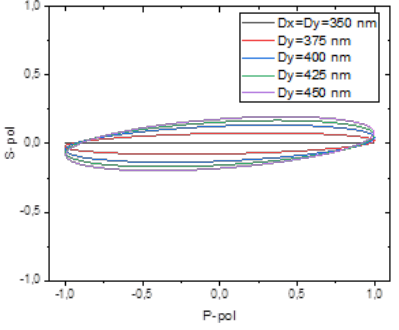
Fig. 2. (a) Set-up for the measurement of angle-dependent, spectrally tuneable circular polarization degree in the output. (b) Wavelength-QWP angle transmission map at normal